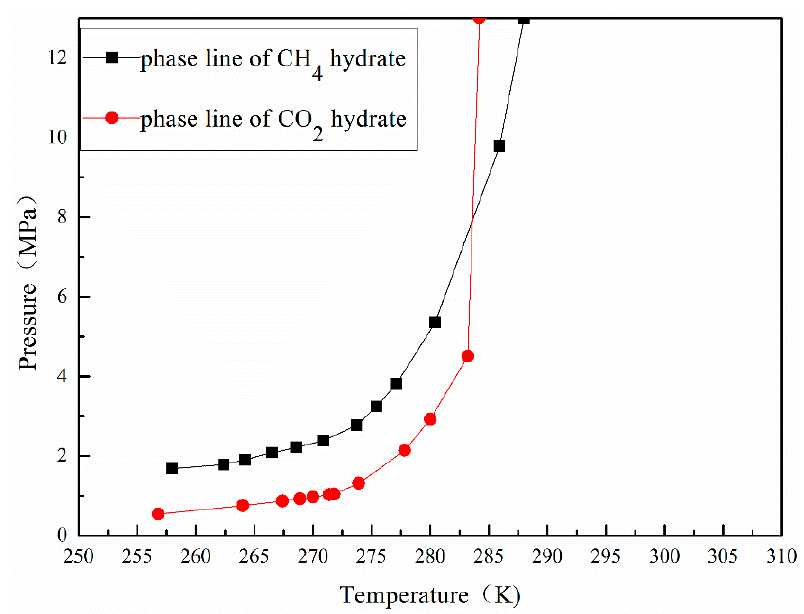
Figure 7. The phase equilibrium of the CO 2 hydrate and the CH 4 hydrate.